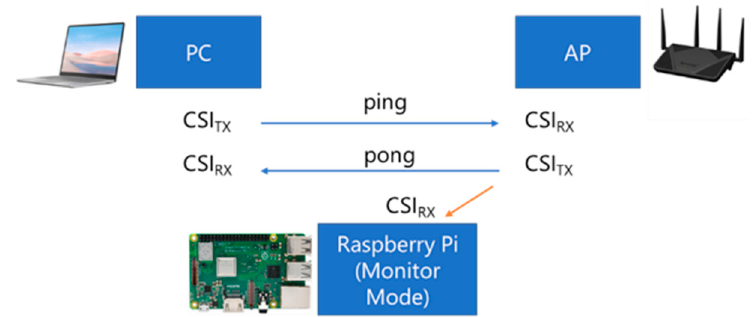
Figure 2. Configuration for CSI data collection in this experiment.